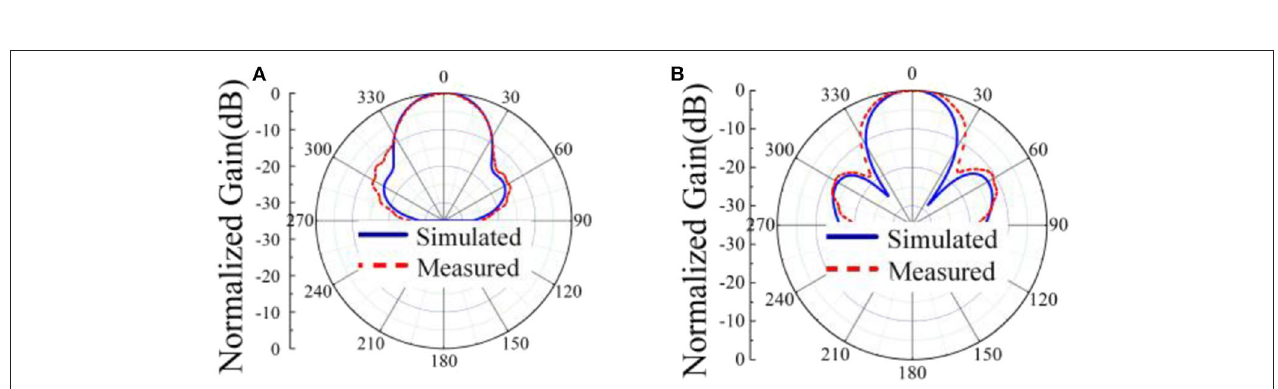
FIGURE 12 | (A) E-plane and (B) H-plane radiation patterns of the type II antenna at 5.7 GHz.